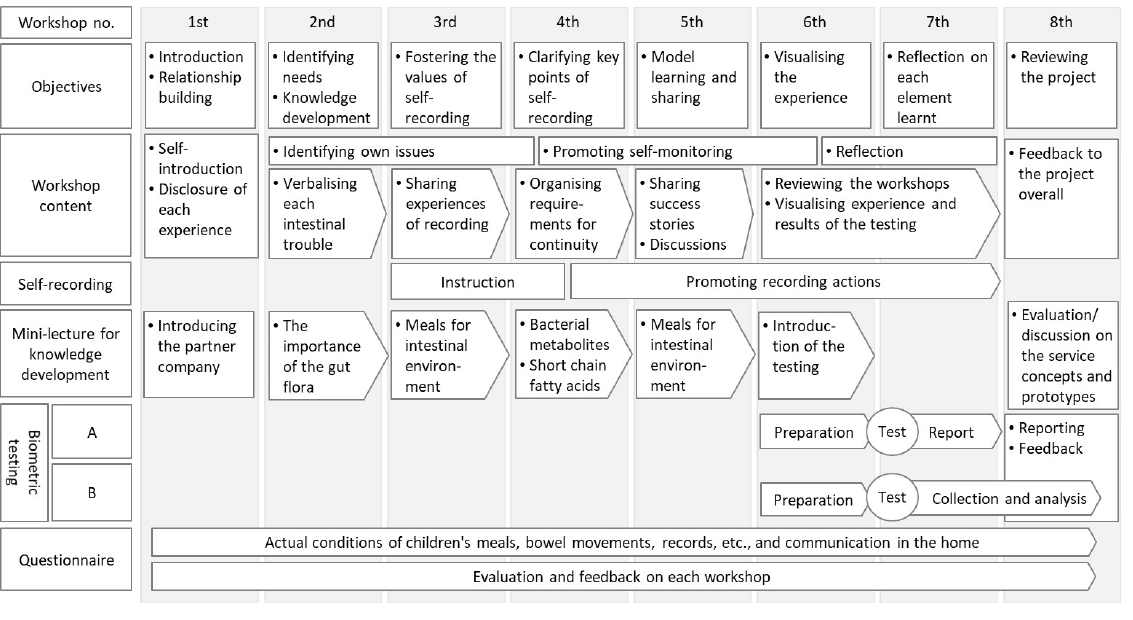
Figure 2. The process and steps of the programme. The self-recording refers to the process of recording the dietary habits of participants and their families by themselves. The bibliometric testing consisted of the existing intestinal microflora test (‘A’) and the short-chain fatty acid simple test (‘B’).